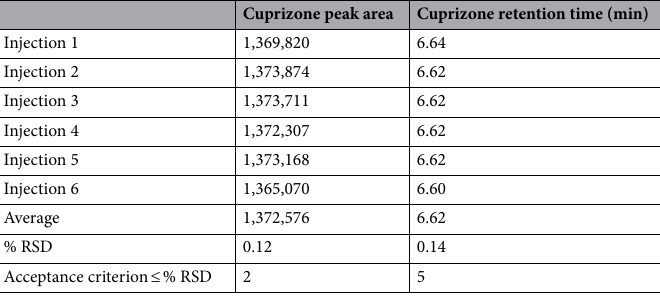
Table 7. The repeatability for the method validation (100 µg/mL reference